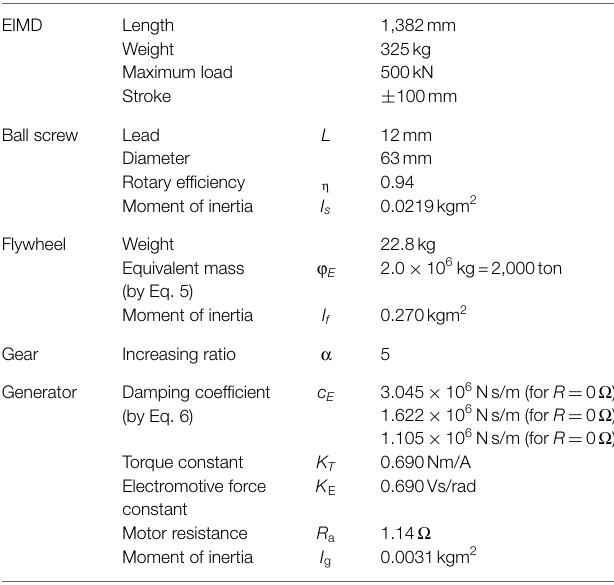
TABLE 1 | Full-size electromagnetic inertial mass damper (EIMD) design parameters .